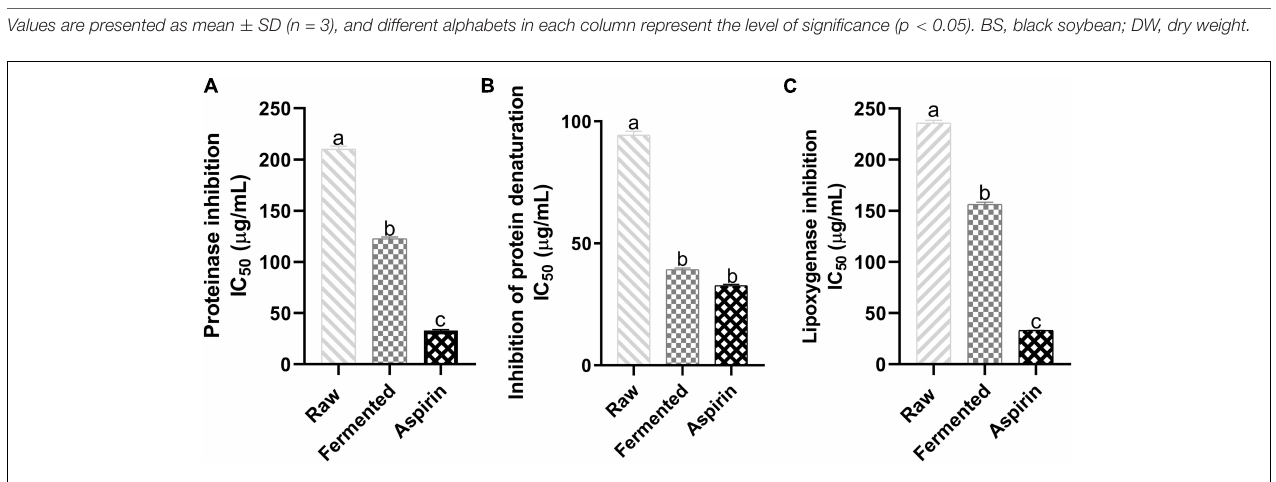
FIGURE 3 | Effect of fermented and non-fermented black soybean samples against inflammatory factors. (A) Proteinase inhibition IC 50 ( µ g/mL), (B) Inhibition of protein denaturation